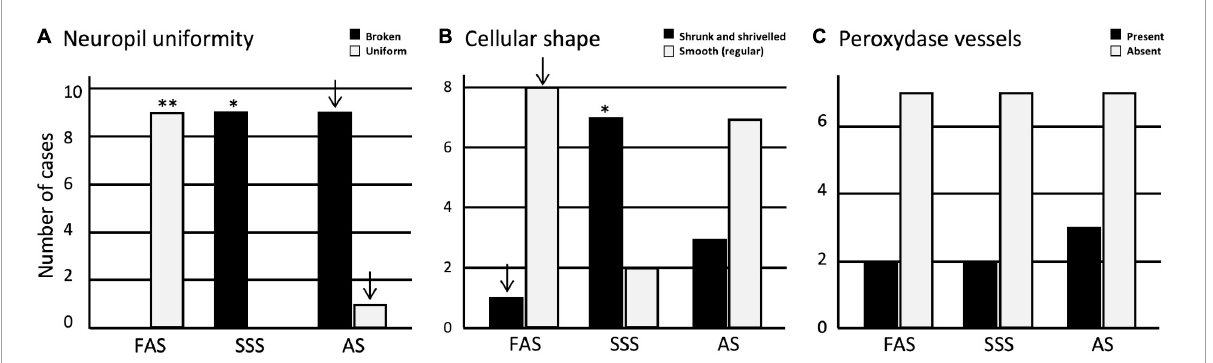
FIGURE4 Bar charts of the tissue quality. (A) Neuropil uniformity; (B) cellular shape; (C) presence or absence of peroxidase vessels. Significance after Bonferroni correction, ∗ p < 0.05, ∗∗ p < 0.001; ↓ = significant before Bonferroni correction; FAS, formaldehyde solution; SSS, salt-saturated solution; AS, alcohol solution.